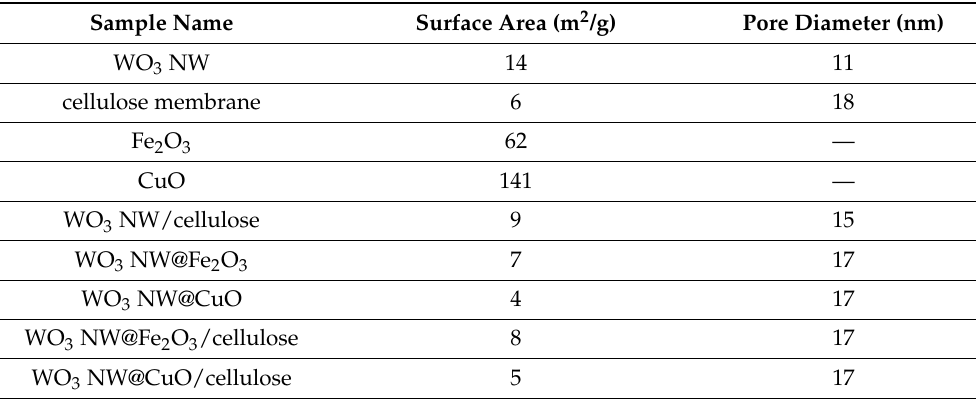
Table 2. Specific surface area results of the pure materials and the hybrid membranes.